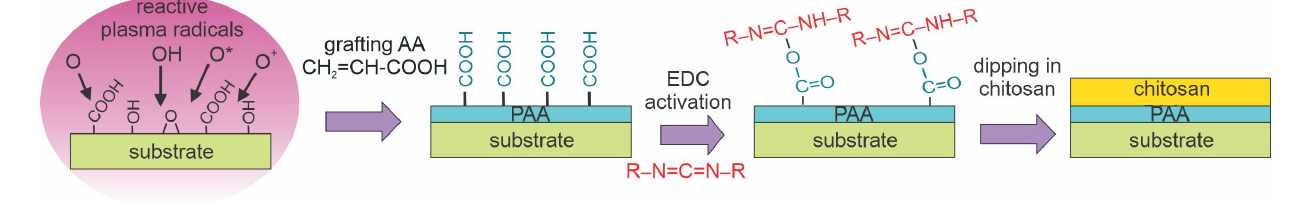
Figure 9. A method for immobilizing a thin chitosan film on plasma-treated samples grafted with an intermediate layer. Oxygen plasma-treated substrates are grafted with acrylic acid to form carboxyl groups, activated with carbodiimide reagent, and dipped into an acidic aqueous chitosan solution.